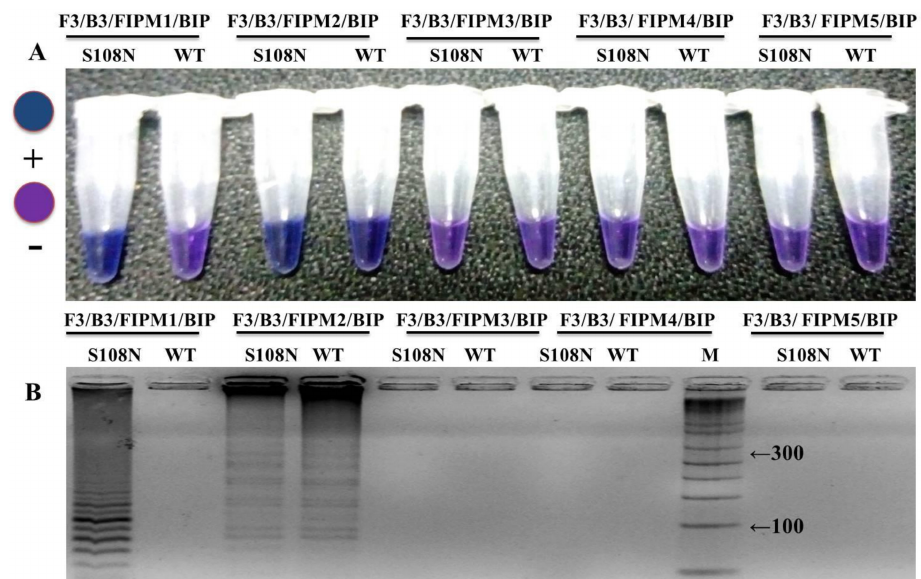
Figure 2. Optimization of in-house designed LAMP primers. ( A ) Assessment was based on the hydroxynaphthol blue (HNB) visualization of the color change in the tube. ( B ) A ladder like pattern was on the gel electrophoresis analysis of the LAMP products for mutant detection.